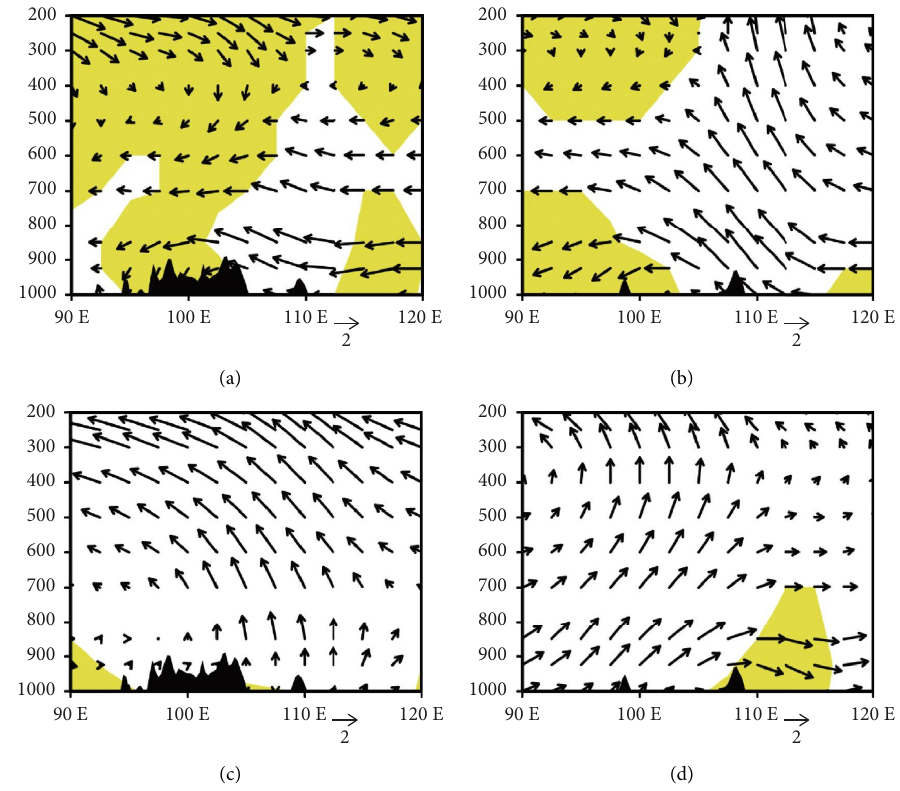
Figure 10: Vertical section of zonal wind (ms − 1 ) and vertical velocity (x 100Pas − 1 ) across 19 o N and 14 o N regressed on the PC1 (a–b) and PC2 (c–d). Te shaded areas indicate anomalous downward motion. (a) PC1, 19 N. (b) PC1, 14N. (c) PC2, 19N. (d) PC2, 14N.